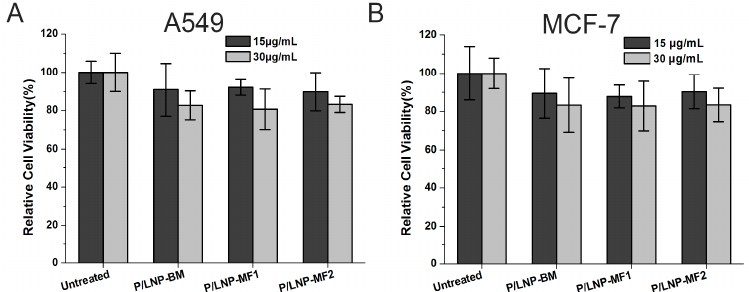
Figure 3. Cytotoxicity studies of P/LNPs using MTT assay on A549 cells and MCF-7 cells. Cells were treated at the transfection concentration (15 µ g/mL) and double transfection concentration (30 µ g/mL) for 48 h, cell viability was measured by MTT assay. ( A ) A549 cells; ( B ) MCF-7 cells. The data are displayed as mean ± SD ( n = 3).